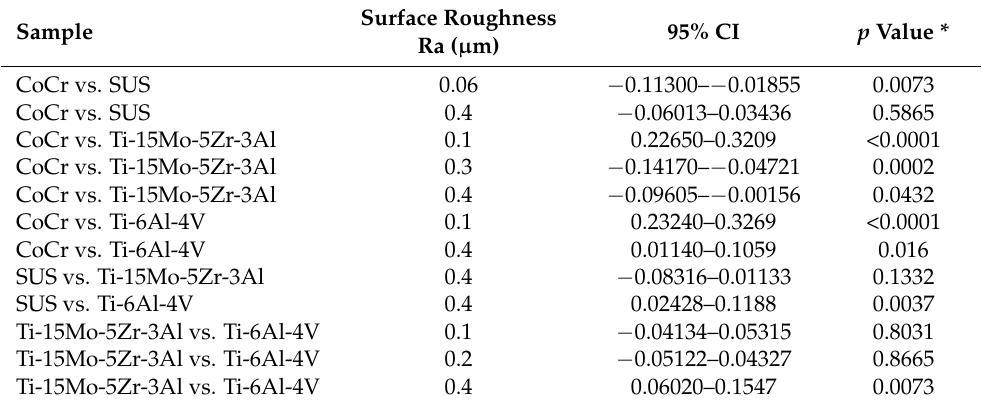
Table 3. Comparisons of frictional coefficient using Endurance (DePuy CMW, Blackpool, UK).